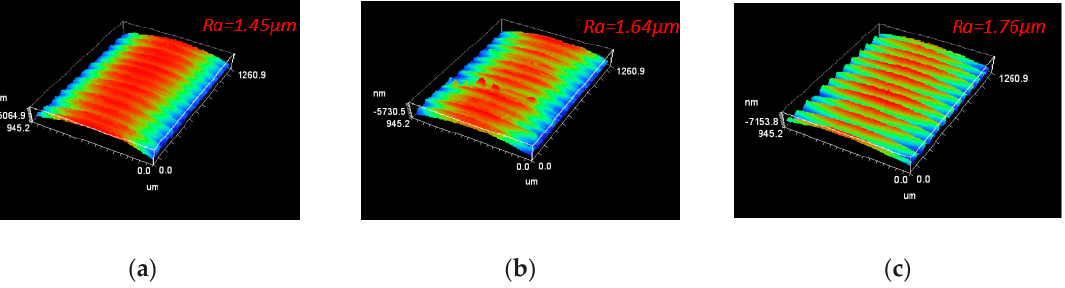
Figure 11. The Surface Roughness Profile of Workpiece: ( a ) d = 80 µm micro-hole tool; ( b ) d = 120 µm micro-hole tool; ( c ) non-textured tool. micro-hole tool; ( c ) non-textured tool.